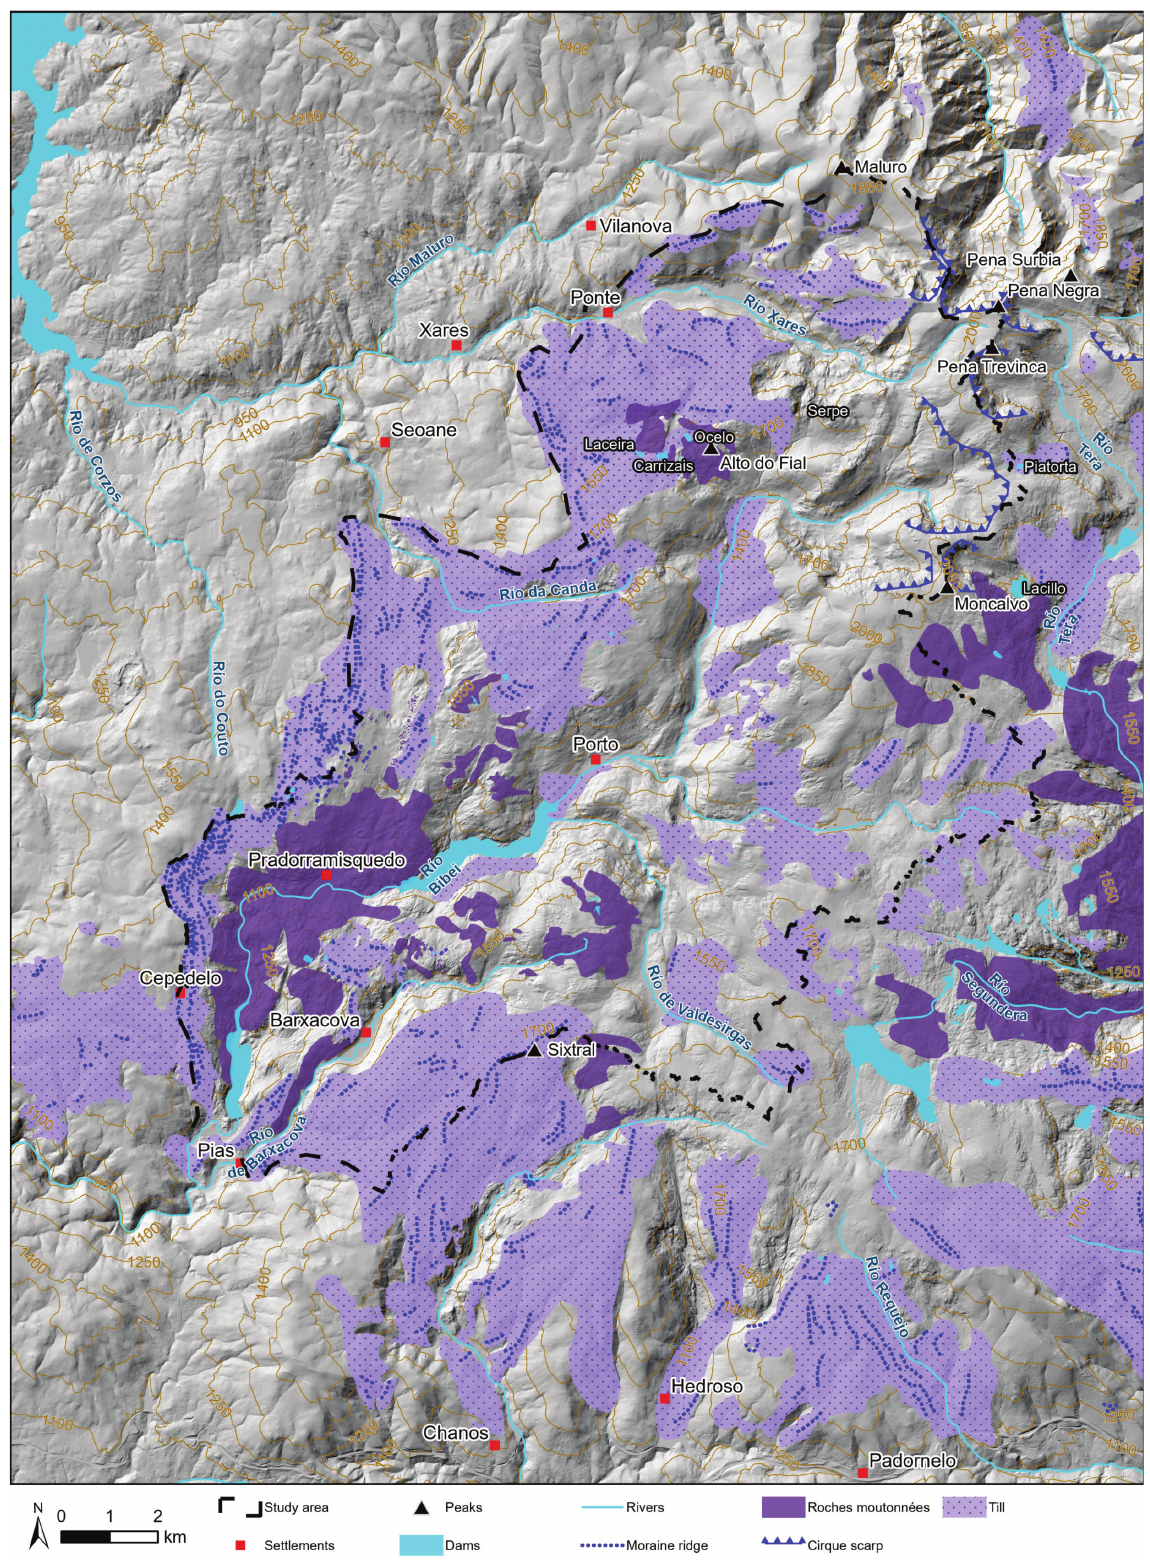
Figure 7. Map of glacial landforms at the occidental Trevinca Massif sector. Location in Figures 1 and